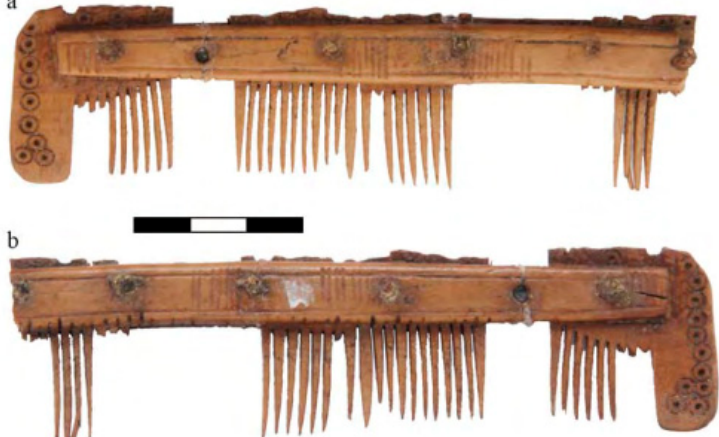
Figure 4. Wrocław—Ostr ó w Tumski (Cathedral Island), No. 4–6 ´sw. Idziego Street, trench IIIF. Deer antler comb, layer E2, catalogue No. 548a/01. Photographs of both sides of the artefact ( a , b ). Photo Figure 4. Wroc ł aw—Ostrów Tumski (Cathedral Island), No. 4–6 ś w. Idziego Street, trench IIIF. Deer by K. Jaworski antler comb, layer E2, catalogue no. 548a/01. Photographs of both sides of the artefact (a, b). Photo by K. Jaworski [41].